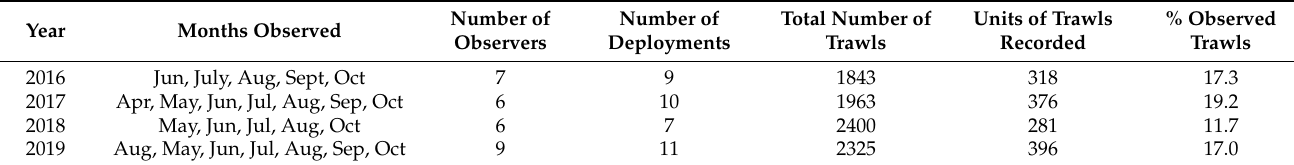
Table 1. Number of observers, deployments, and hauls during the study